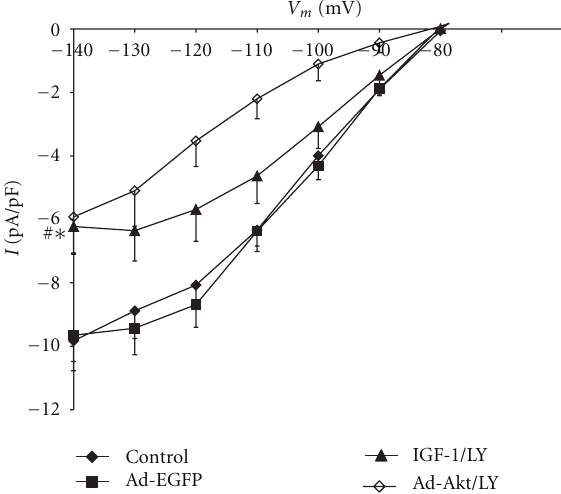
Figure 7: E ff ects of IGF-1 and Ad.Akt in combination with LY294002 treatments on the I K1 -voltage relationship for normal neonatal rat cardiomyocytes. Data are presented as average current density (pA/pF) ± standard error. ∗ # Significant di ff erences at P < 0 . 05 for control and Ad.EGFP versus IGF-1 and Ad.Akt in combination with LY294002 treatments.